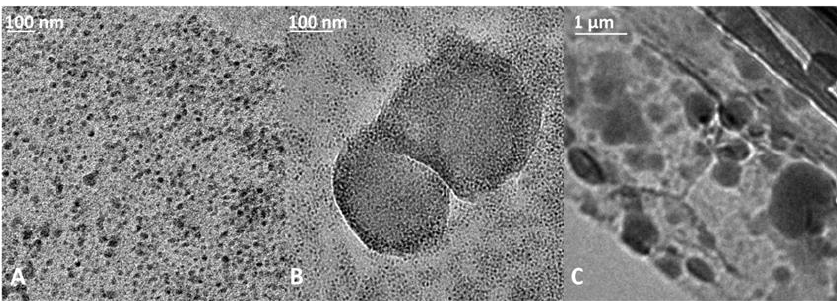
Figure 3. Images from HR-TEM of: ( A ) niosomes in MilliQ water; ( B ) niosomes in MilliQ and glycerol; ( C ) niosomes in MilliQ and PEG400.